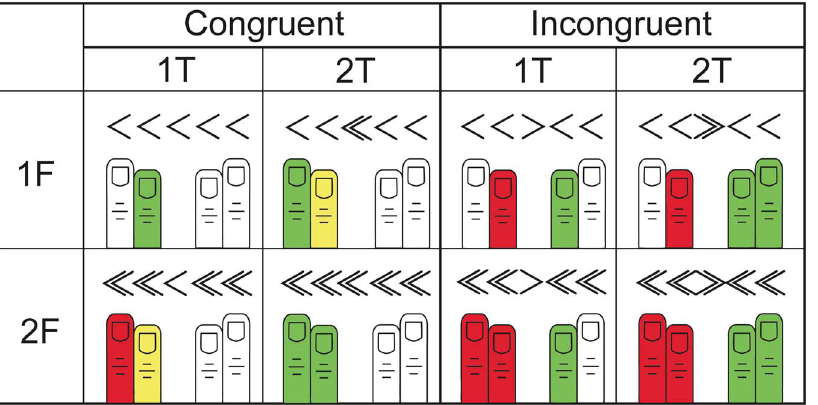
Figure 1. Experimental design. The stimuli (target and flankers) in each type of trial in the incongruent and congruent direction conditions are shown along with cartoons of the corresponding fingers involved. Target (correct) responses (green) with one (1T) or two (2T) fingers were indicated by a single arrowhead or double arrowhead target stimulus, respectively. Similarly, incorrect (flanker) responses (red) with one (1F) or two (2F) fingers were induced by single arrowhead or double arrowhead flanker stimuli, respectively. Yellow indicates fingers that were involved in both the error and correct responses, and thus did not have independent representation. White indicates fingers that were not involved in either response option.